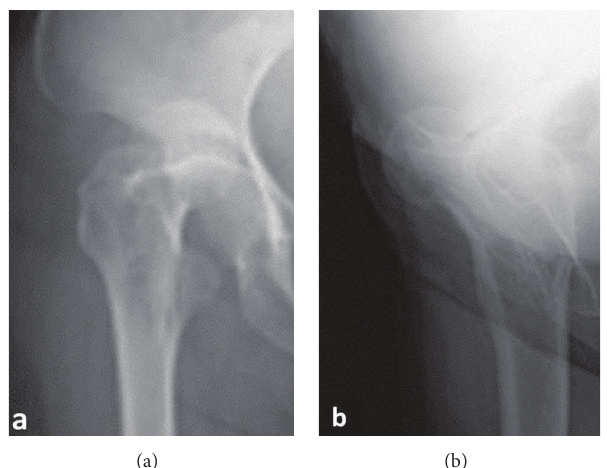
Figure 1: Plain radiographs of the hip joints at the initial visit. (a) Anteroposterior image. (b) Lateral image. These images show anterior dislocation of the right hip joint.